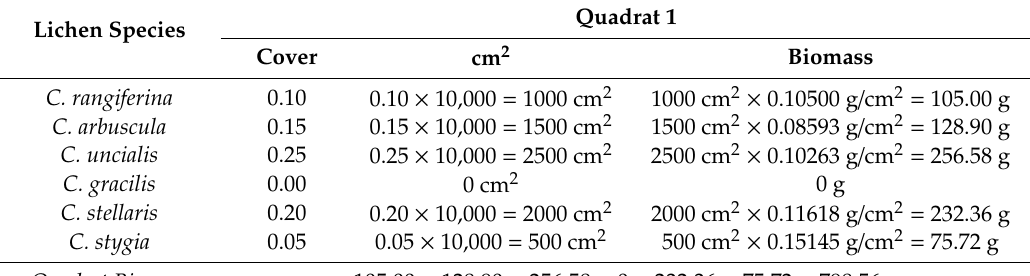
Table A1. Example calculation to estimate the biomass of Cladonia spp. ground lichens in a 1 m 2 quadrat. Species classification and conversion factors are adapted from McMullin et al. (2011) [33].